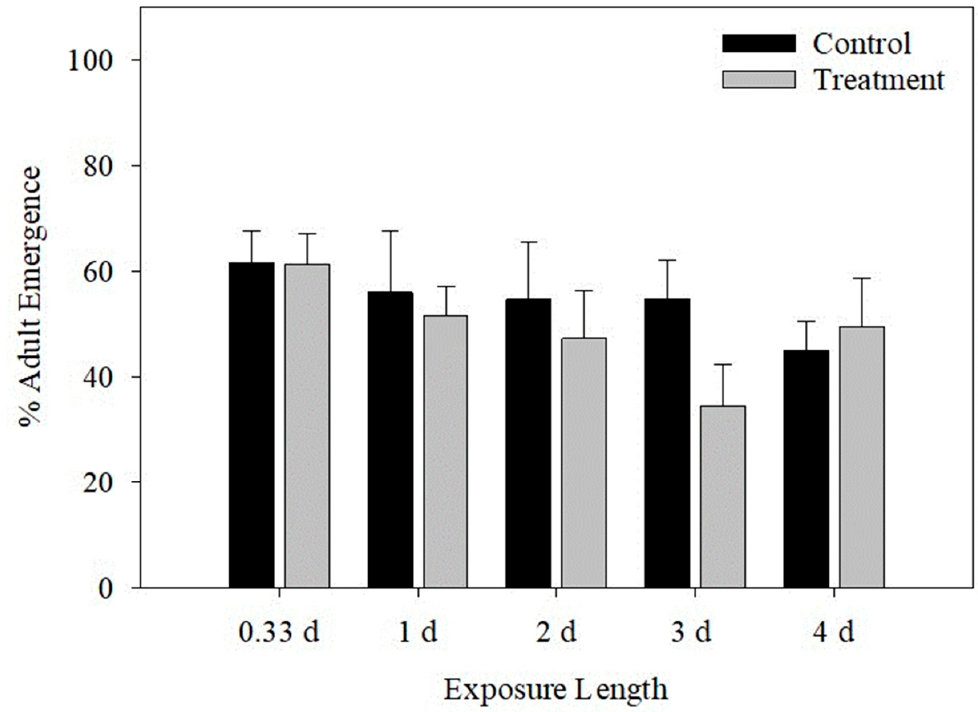
Figure 2. Percent (mean ± SE) adult emergences from T. granarium larvae exposed on control (black bars) or deltamethrin-treated packaging (gray bars) for 0.33–4 days.